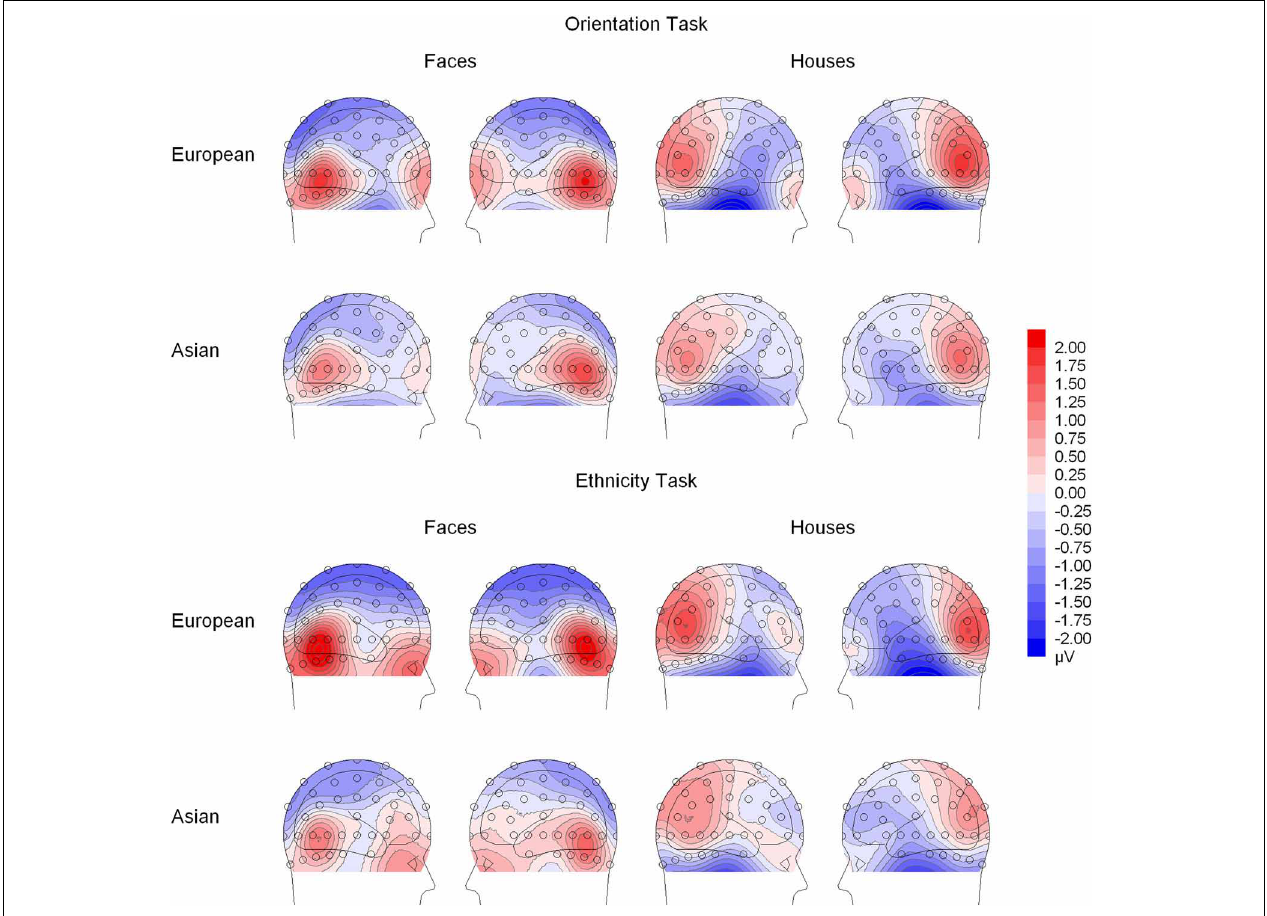
FIGURE 4 | Scalp-topographical voltage maps (spherical spline interpolation, 90 ◦ equidistant projection) depicting the inversion effect (upright— inverted conditions) in the N170 time